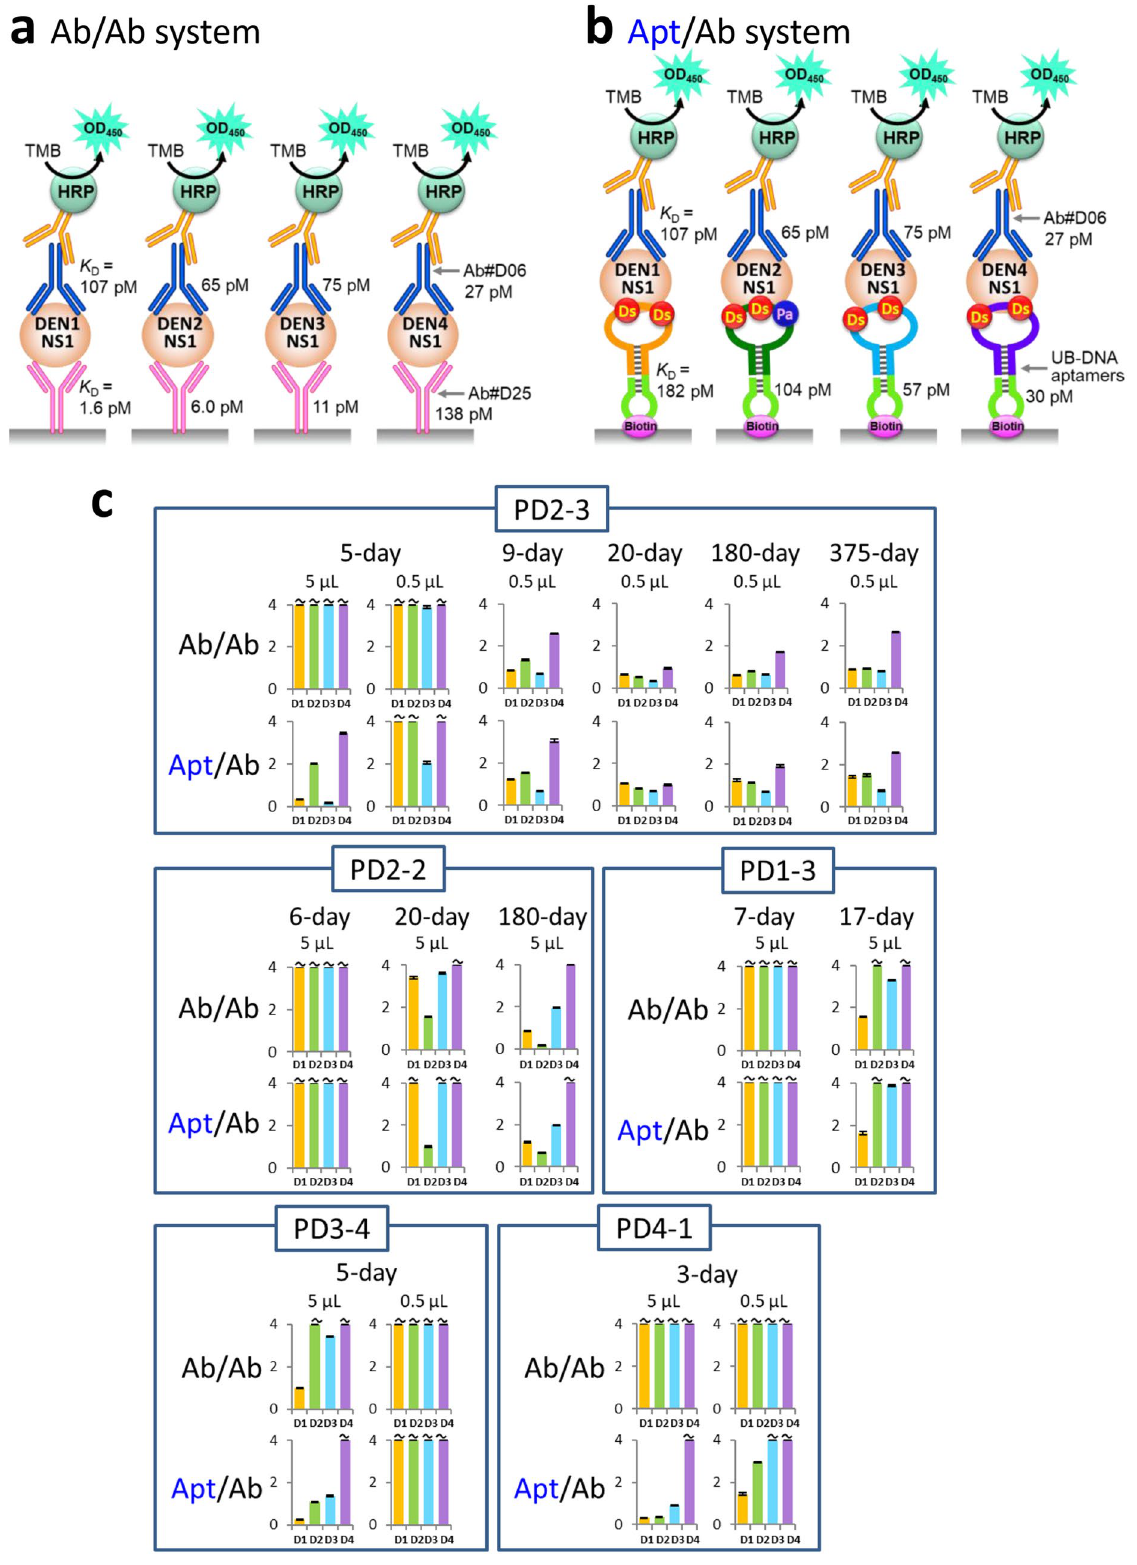
Figure 7. Comparison of the competitive ELISA formats between aptamer–antibody (Apt/Ab) and antibody– antibody (Ab/Ab) sandwich systems. (a,b) Schematic representation of the components in each system, using four DEN-NS1 serotypes. In the Ab/Ab system, the same antibodies for the capture and detection reagents were used. In the Apt/Ab system, each UB-DNA aptamer was used for each DEN-NS1 serotype. (c) Comparison of ELISA signal patterns (inhibition) of each clinical sample in different time